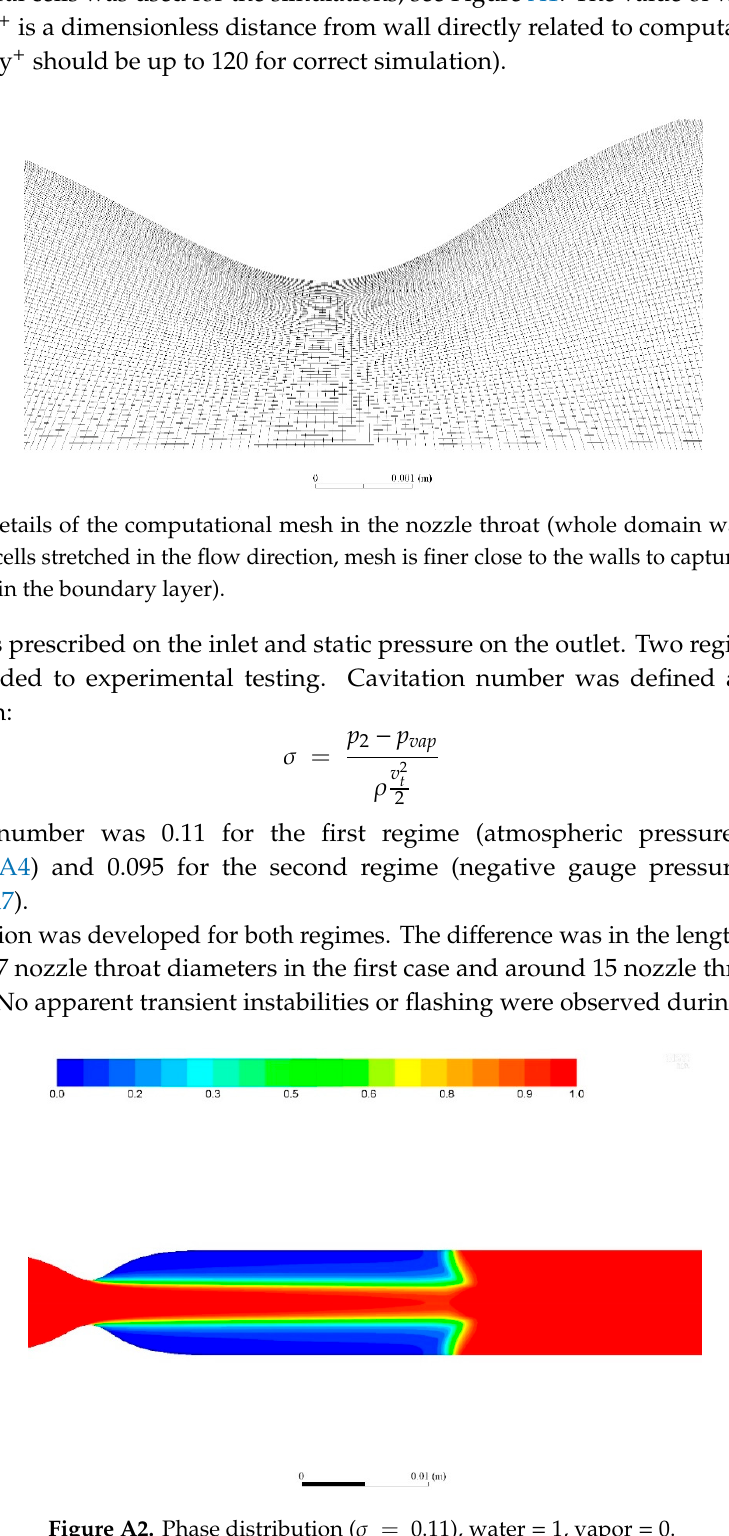
Figure A2. Phase distribution ( 𝜎 = 0.11 ), water = 1, vapor = 0.